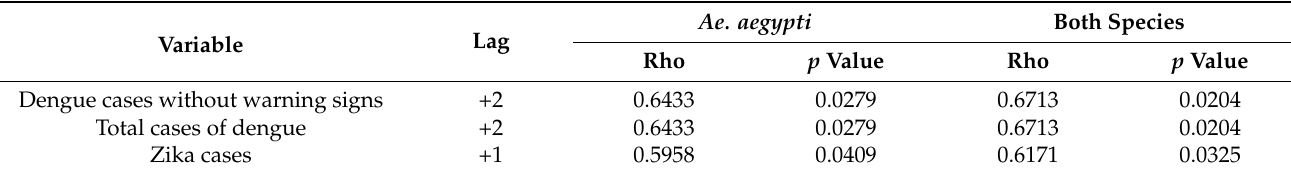
Table 5. Statistically significant correlations at 95% confidence between vectors IRs and epidemiological (reported cases) and virological (pathogen IRs) variables. No significant correlations were recorded for Ae. albopictus species. Ae. aegypti Both Species Variable Lag Rho p Value Rho p Value Dengue cases without warning signs